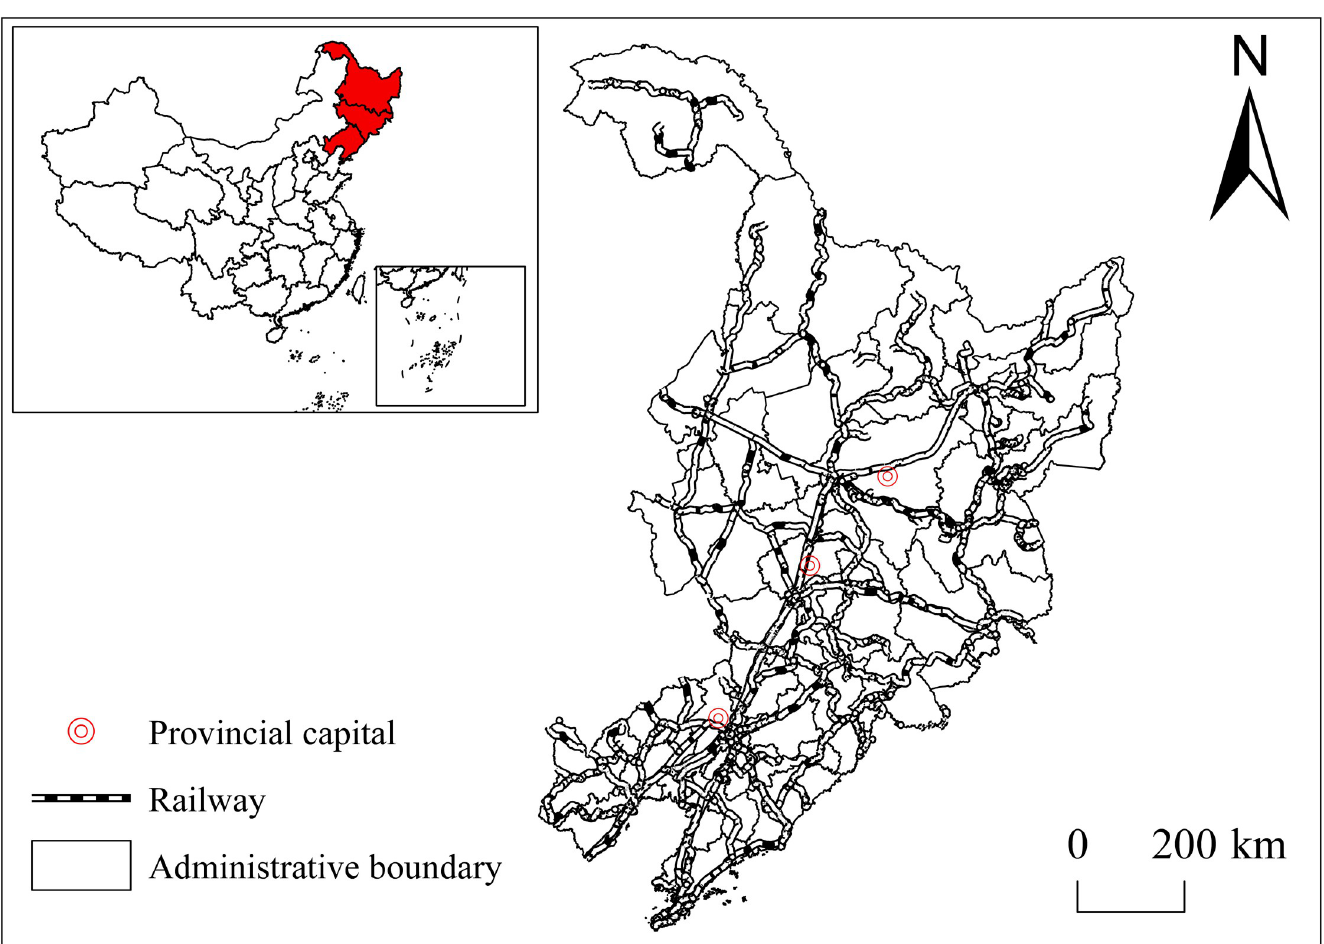
Fig 1. Administrative division and railways of the three northeastern provinces. Note: The basic map came from a public map from the standard map service website of the Ministry of Natural Resources of China. The drawing approval number is GS (2016)1593.